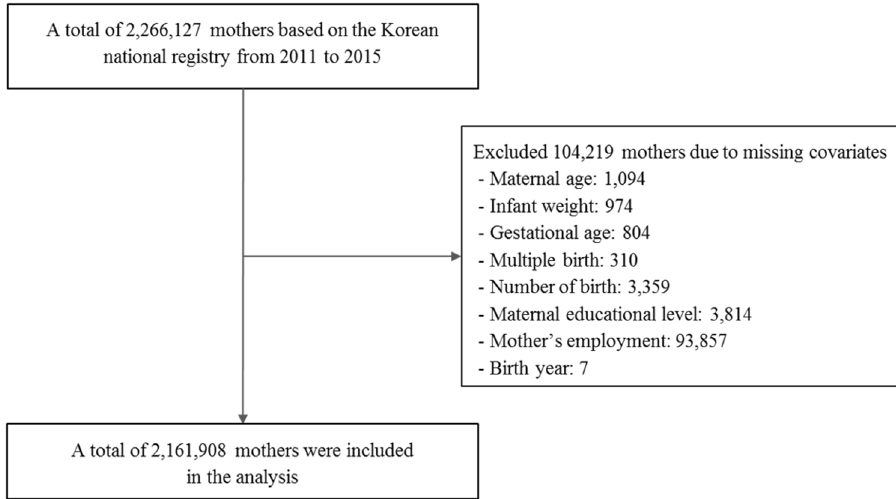
Figure 1. Flow diagram of the study